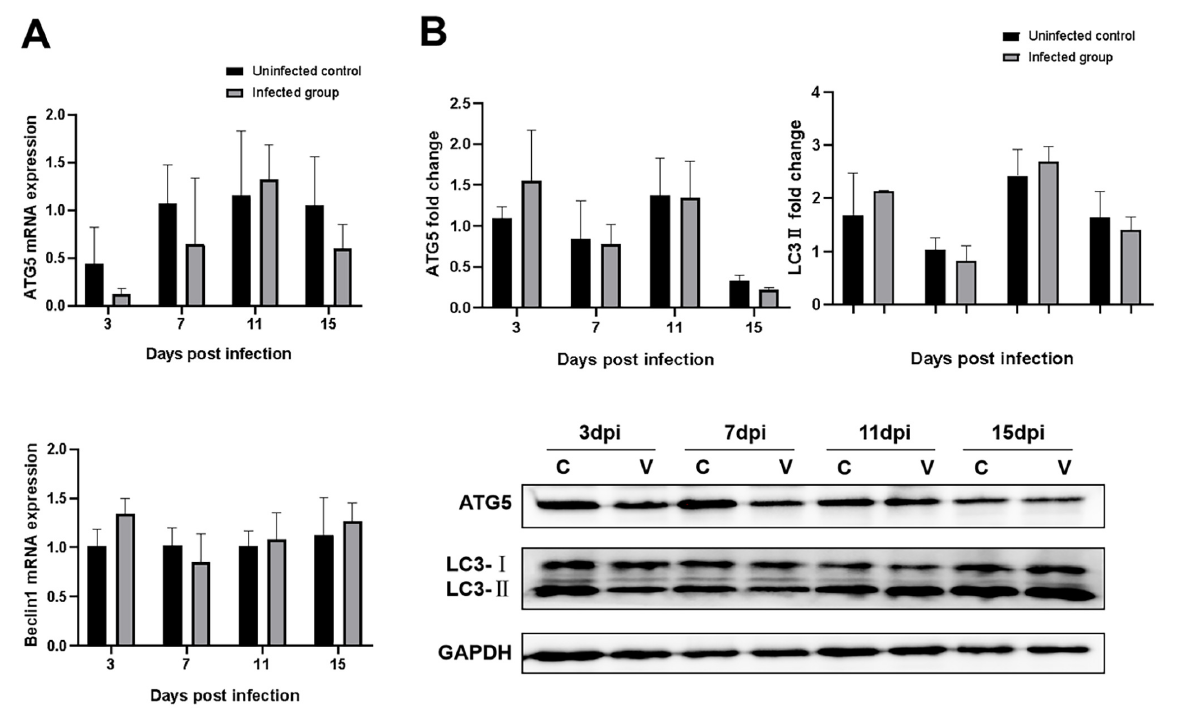
Figure 8. Effects of GNAstV infection on autophagy of splenic cells. Changes in the mRNA levels of ATG5 and Beclin1 in spleen tissue at 3, 7, 11, and 15 dpi after infection with GNAstV ( A ). Changes in the protein levels of ATG5 and LC3-II in spleen tissue at 3, 7, 11, and 15 dpi after infection with GNAstV ( B ). C: uninfected control group; V: GNAstV-infected group. Values are expressed as mean ± SD, n =